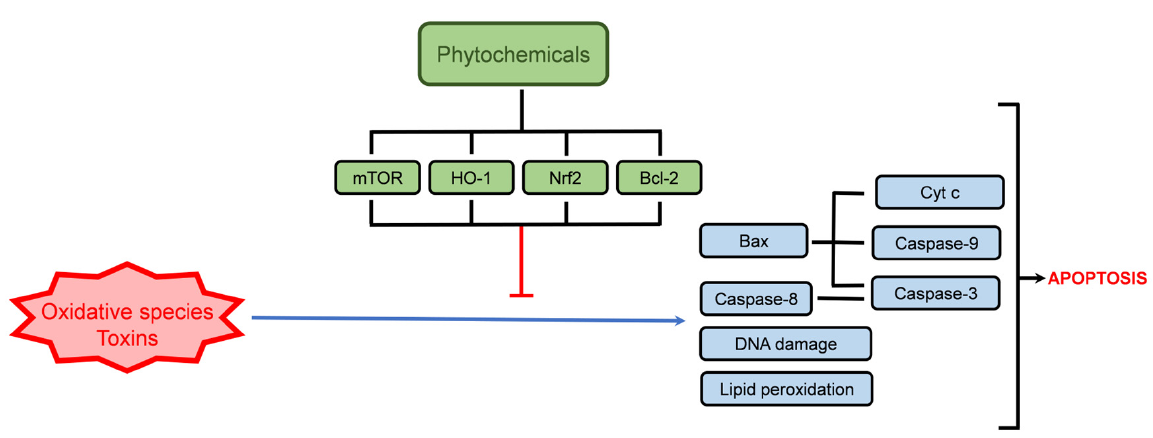
Figure 5. Schematization of main cellular targets of phytochemicals that participate in cell protection against xenobiotic-induced apoptosis.